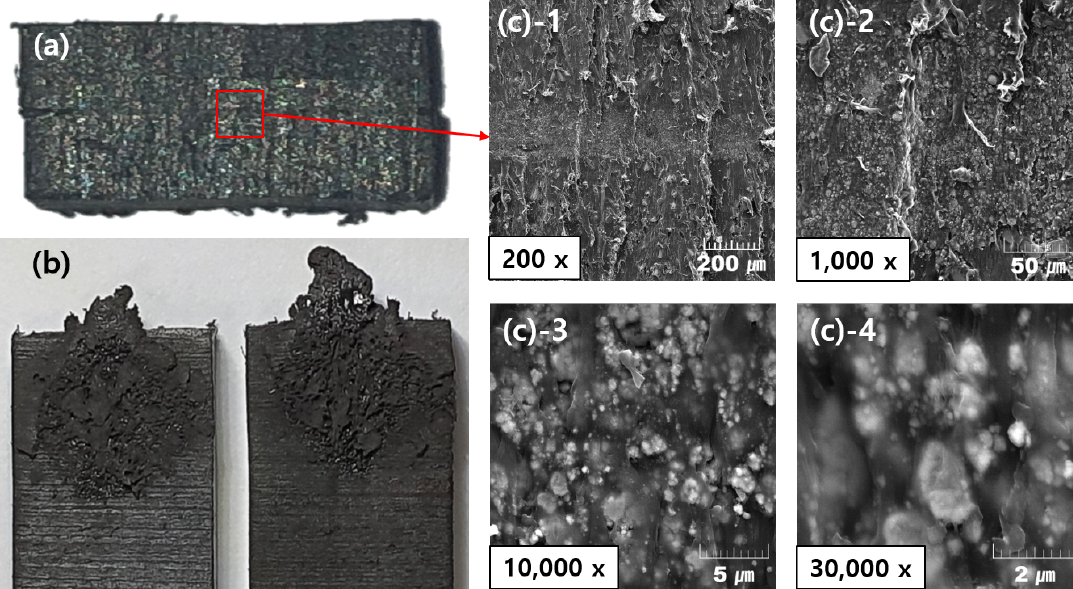
Figure 8. Cross-sectional SEM images of the weld joint at magnifications of 200–30,000: (a) Cross-section of specimen of the induction welding, (b) The appearance of the welded section, (c) Cross-section of induction welded specimen with